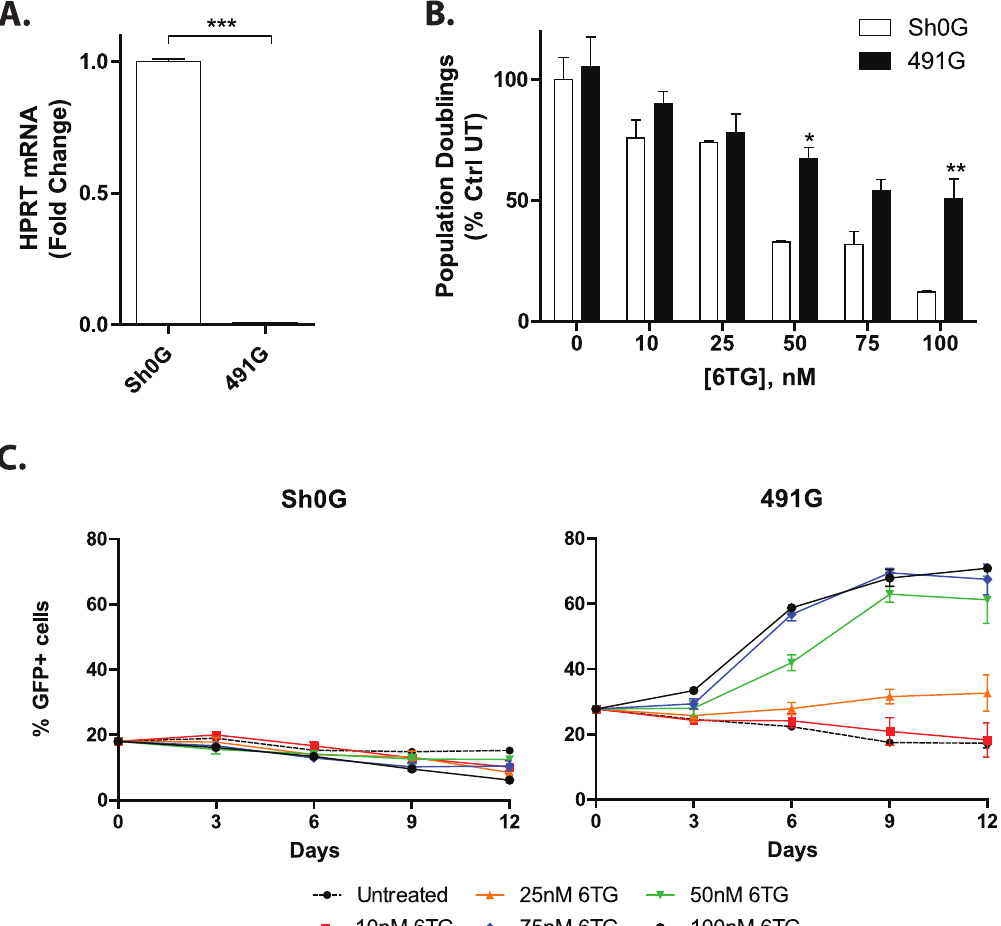
Figure 2. Knockdown of HPRT confers resistance to 6TG in human umbilical cord hematopoietic progenitor cells. A. Construct 491 efficiently depletes HPRT expression in human umbilical cord hematopoietic progenitor cells. CD34 + cells isolated from human umbilical cord blood were transduced with vectors expressing GFP and shRNA against HPRT (sh491G) or non-silencing control (sh0G). Cells were sorted for GFP expression, total RNA was isolated and analyzed by reverse transcription, real time PCR. Construct sh491G reduced HPRT expression by 90%. B. Human HPC with reduced HPRT continue to proliferate in 6TG. Cells were transduced as in A, and unsorted cells were cultured in the presence of cytokines, with re- seeding in fresh media and 6TG every 72 hours. Cells were assessed by flow cytometry for GFP, propidium iodide exclusion and counting every 72 hours. The number of population doublings of GFP + cells at day 6 was determined, and is depicted as a percentage of untreated, non-silencing control transduced cells. C. Knockdown of HPRT allows for selection of transduced cells in 6TG. UCB cells were transduced, cultured and treated as in Figure 2B. The percentage of GFP + cells was measured every 72 hours. Note the dose dependent increase in GFP + cells with time in cells transduced with 491G.